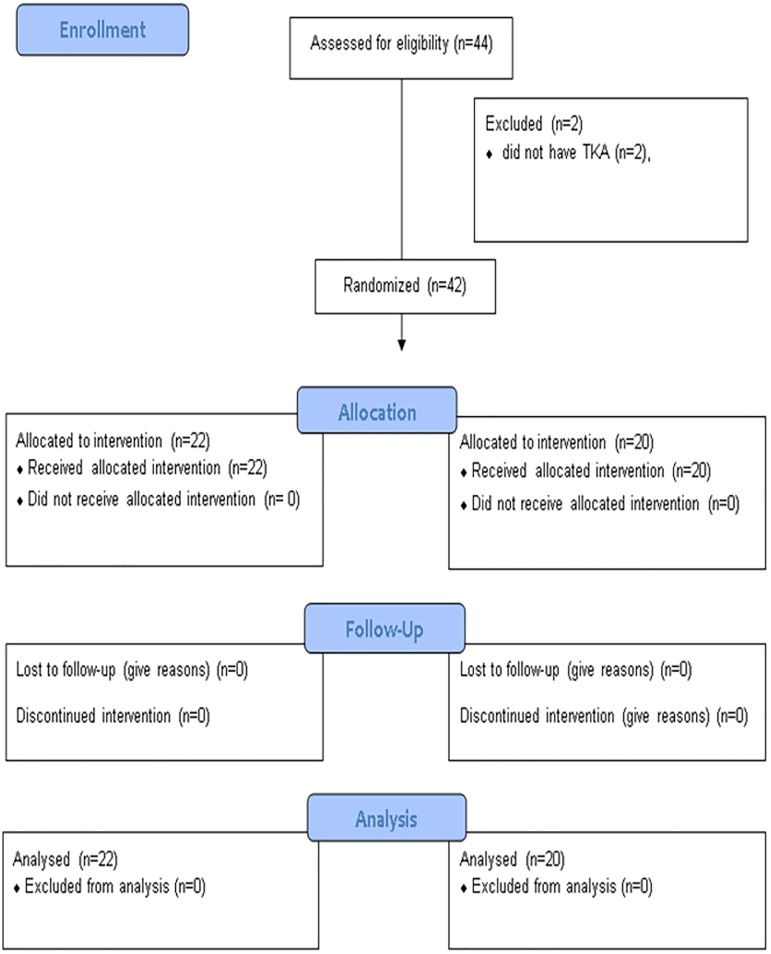
Study flow chart.